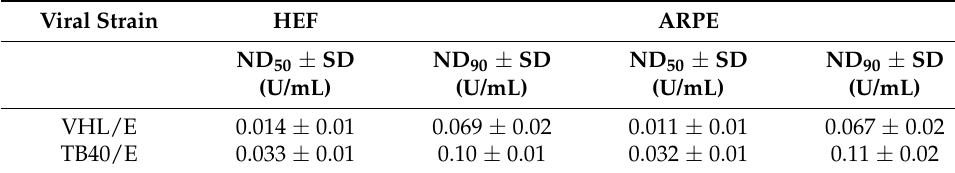
Figure 2. Neutralization activity of Cytotect CP ® in vitro. The number of foci after the neutralization assay were counted for ( A ) the TB40/E strain and ( B ) the VHL/E strain on human embryonic fibroblast HEF cells and epithelial ARPE-19 cells after 5 days of incubation ( n = 3 assays). Table 1. In vitro neutralizing efficacy of Cytotect CP ® . The efficacy of the compound was analyzed against the TB40/E and VHL/E strains on human embryonic fibroblast HEF cells and epithelial ARPE-19 cells. The 50 and 90% neutralizing dose (ND 50 and ND 90 ) values were determined using the results from Figure 2 with GraphPad Prism